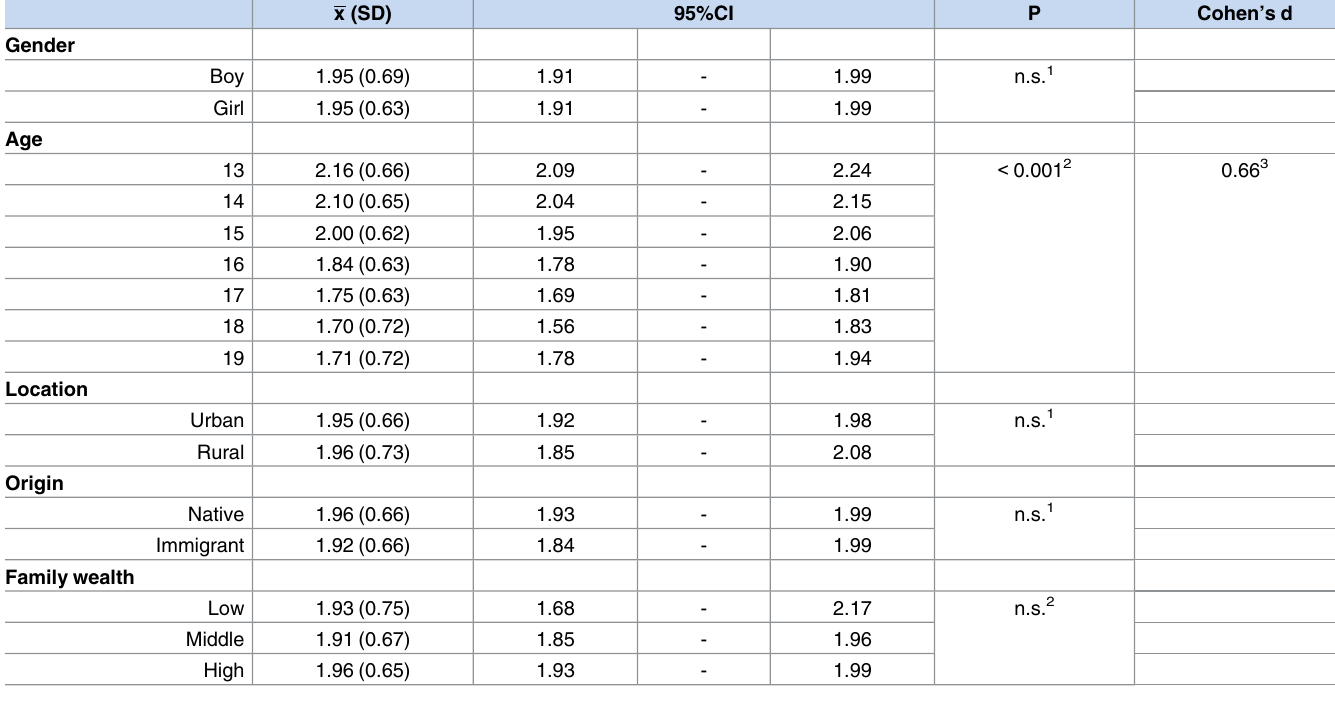
Table 7. Descriptiveanalysis of the RULT component with respect to the different